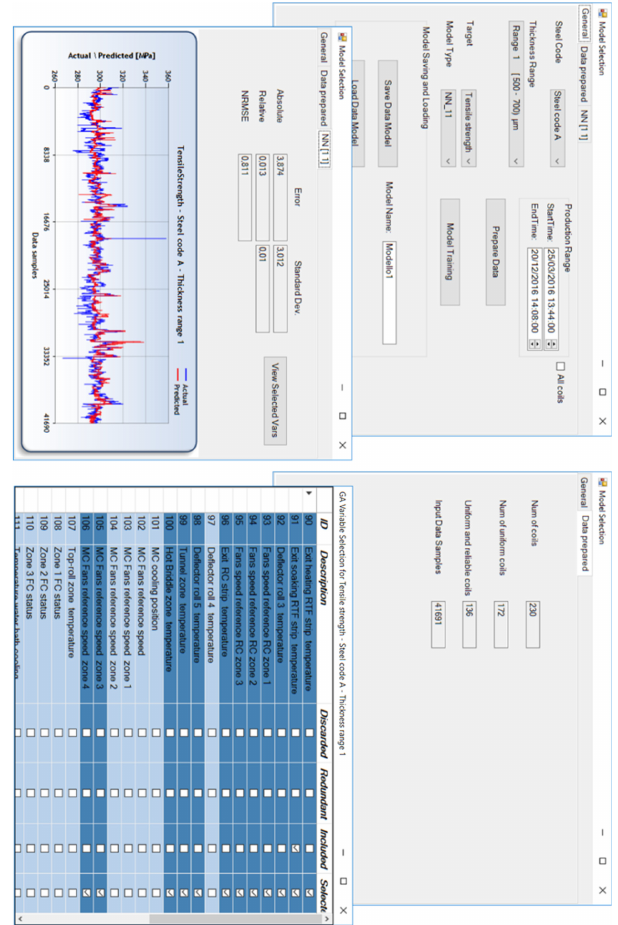
Figure 8. Exemplar screenshots of the user-friendly interface for data selection and models tuning.